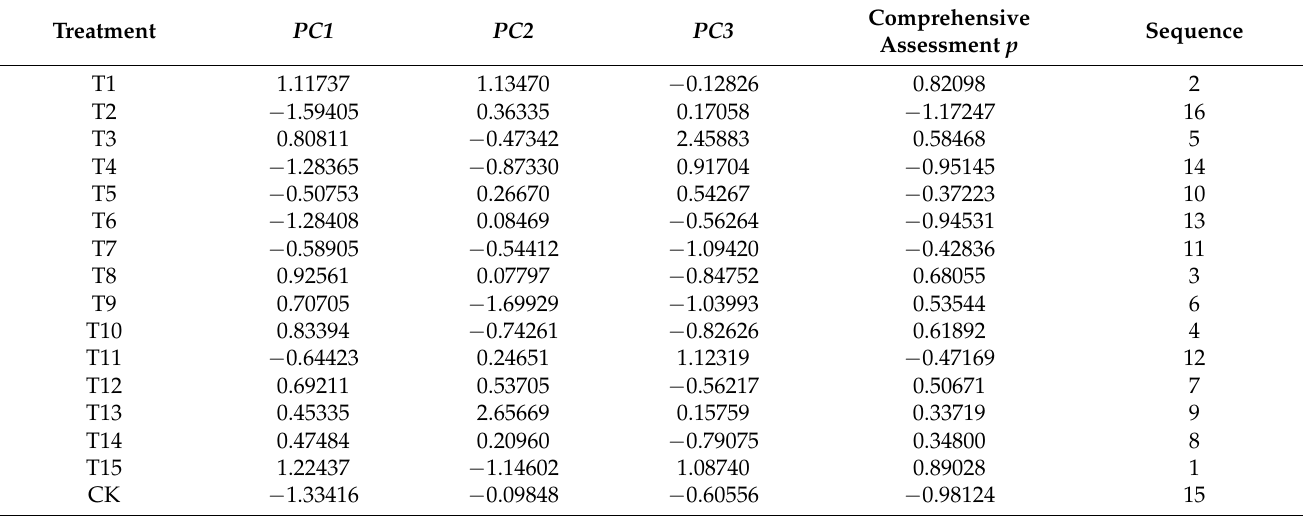
Table 5. Comprehensive scores of principal components (PC) of H. chrysanthus with different mixed substrates.